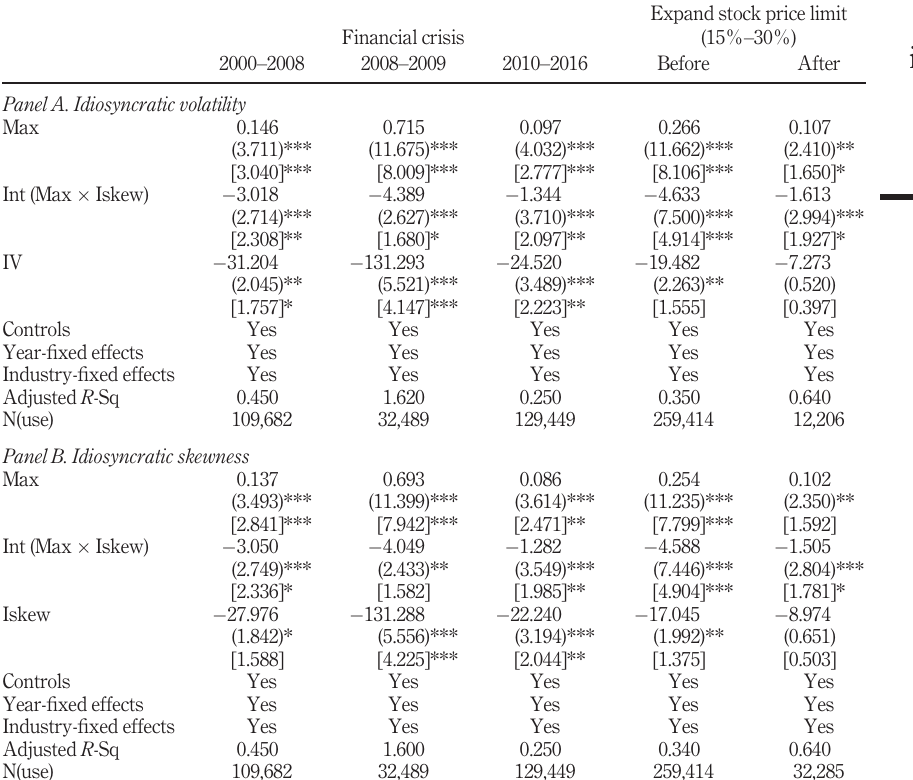
Table 6. Subperiod